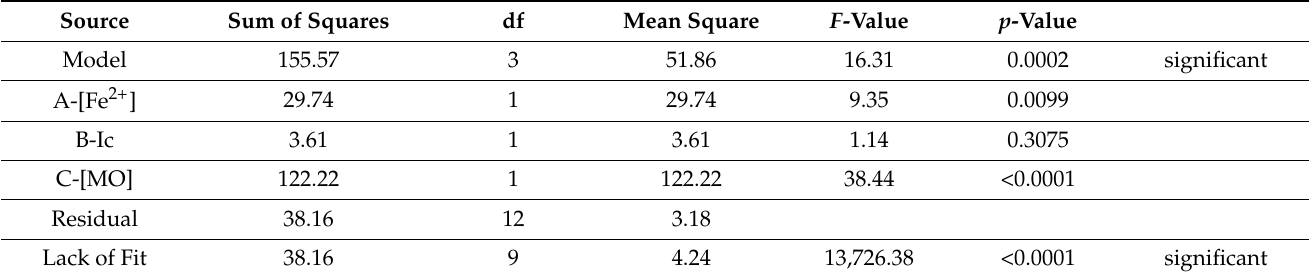
Table 1. ANOVA analysis of the model.